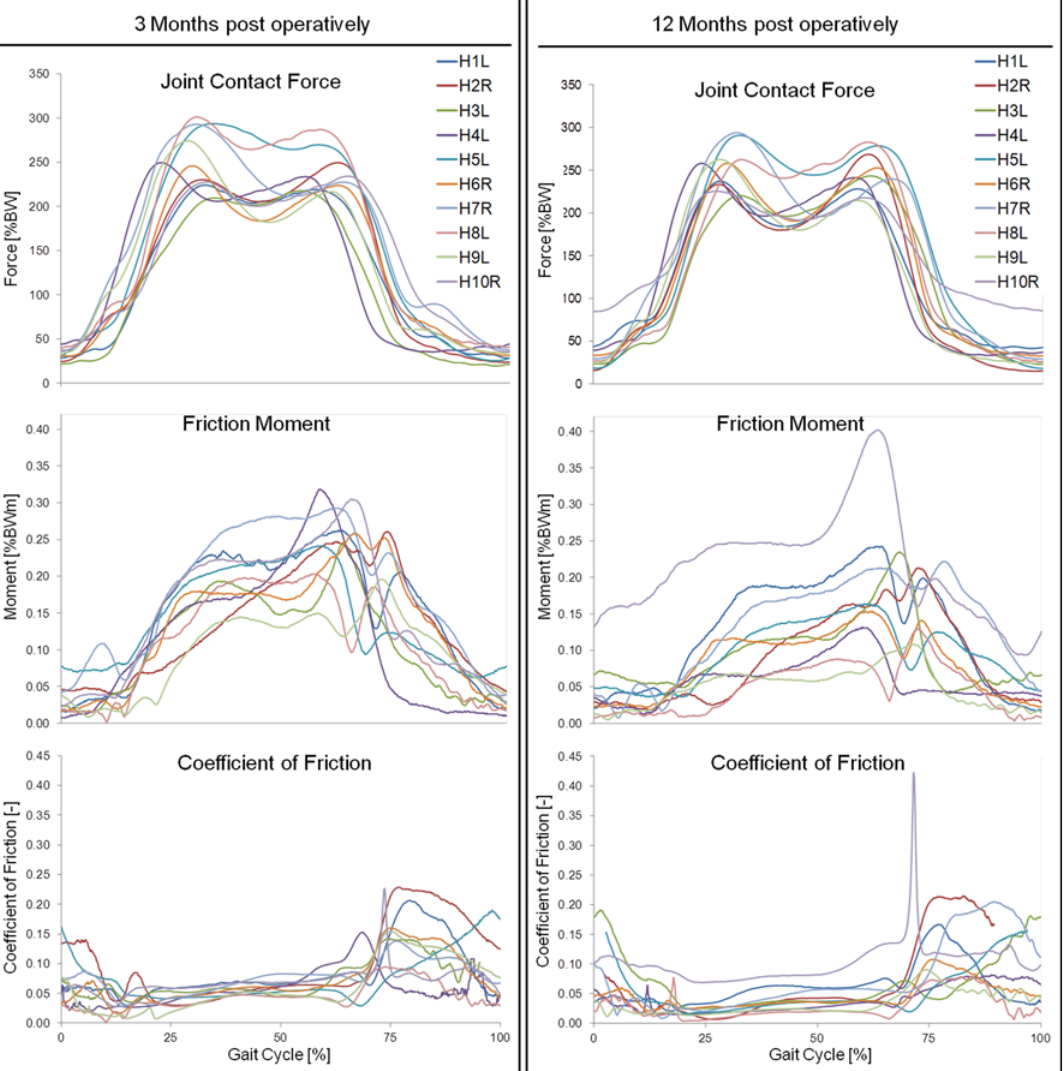
Fig 4. Individual contact forces, friction moments and coefficients of friction. Load pattern during one gait cycle at three (left) and twelve (right) months